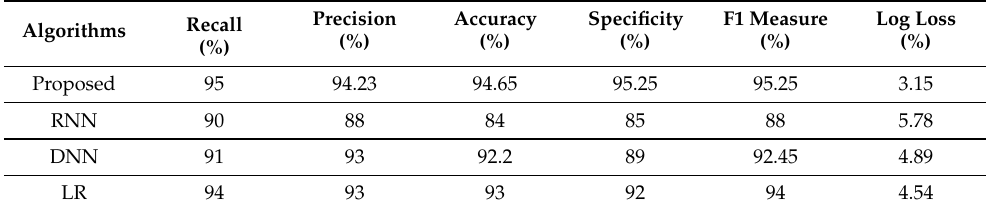
Table 4. Attack Classification Analysis: Ping DDoS.